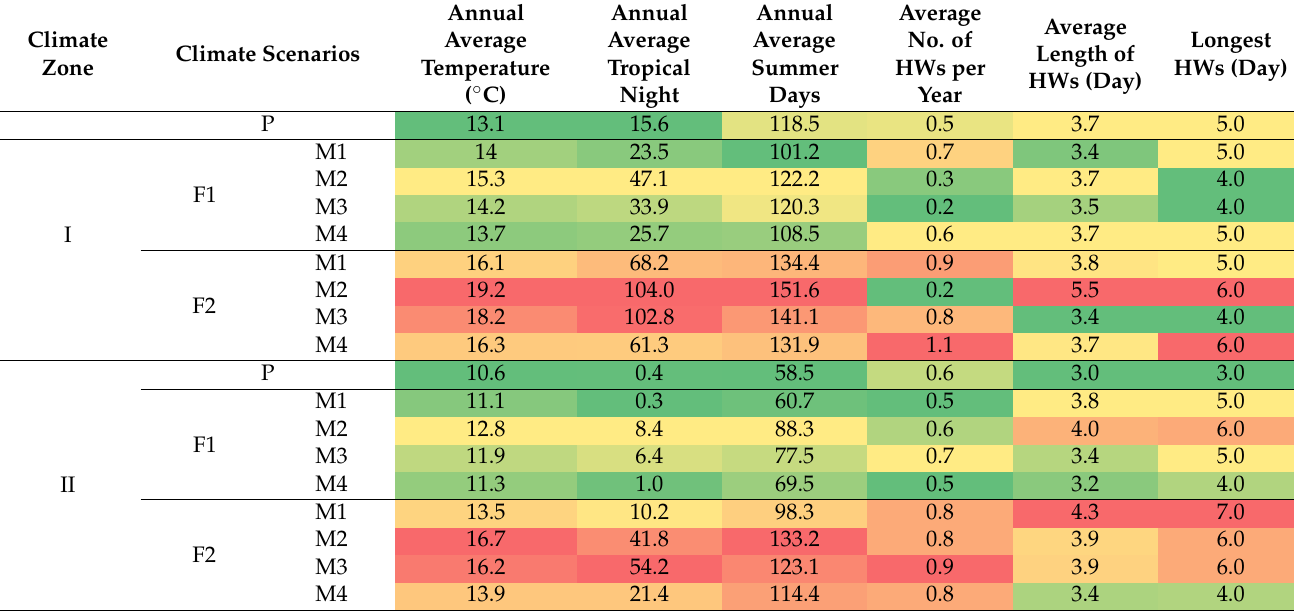
Table 6. Current state and projected changes of the temperature and extreme heat events in Climate zone I and II. P = 2008–2018, F1 = 2041–2050, F2 = 2091–2100; M1-4, refer to the climate models in Table 2; HWs = Heatwaves. For each column, the colour of table switches from green to red according to the relative severity of the